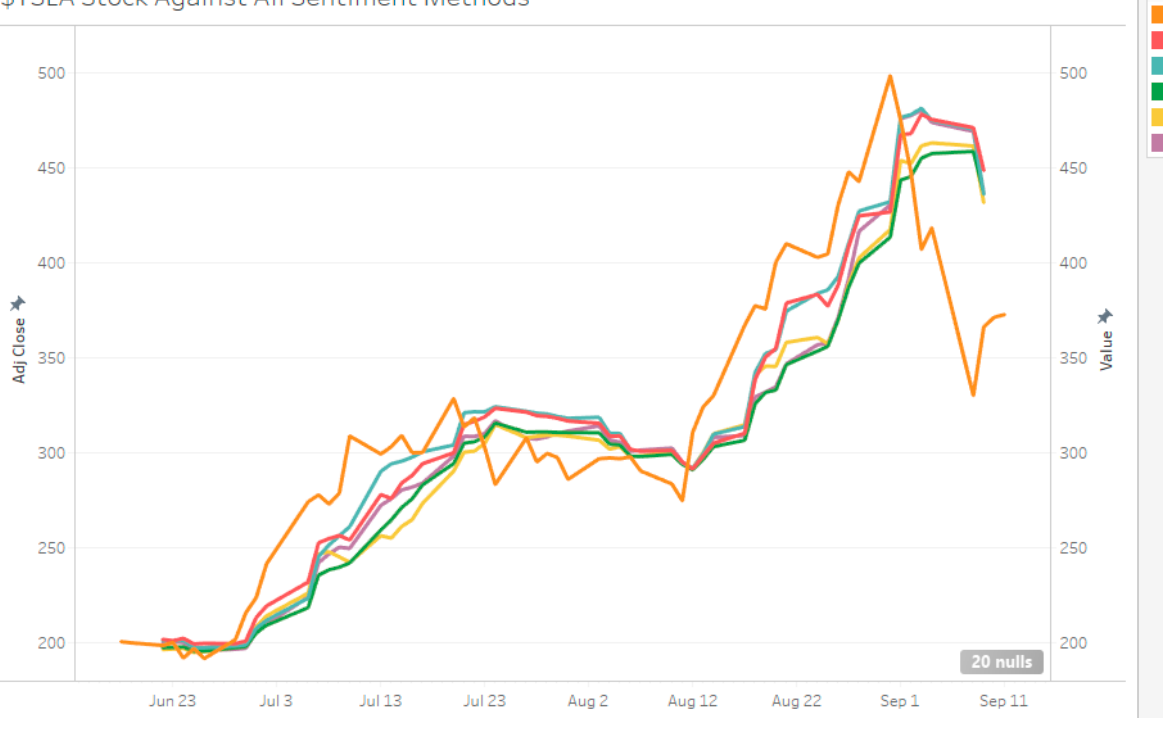
Figure 14. All SA-LSTM Model Comparison—TSLA.